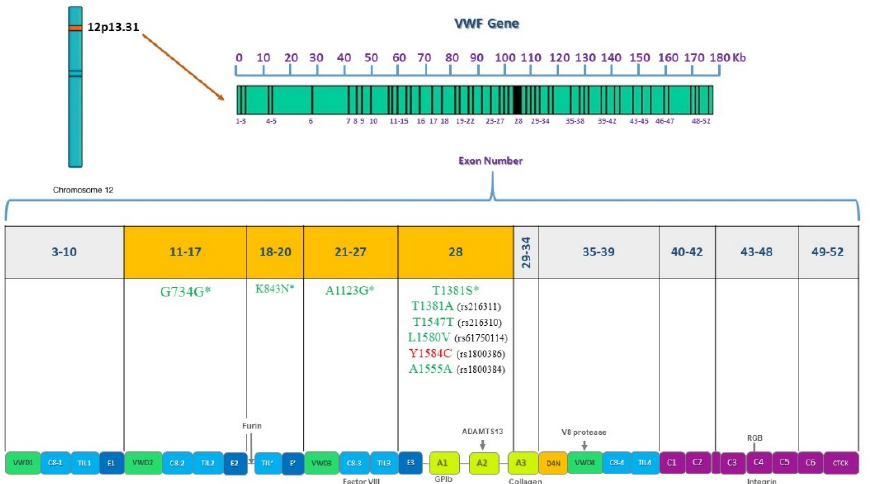
Figure 9. Pathogenic or benign variations found by VWF gene and protein domain. VWF is located on chromosome 12, 52 exons are shown and their corresponding domains in the VWF protein. Sequenced exons from 11 to 28 are highlighted in orange. Deleterious variations appear in red and benign variations in green. Asterisks indicate novel variations found.